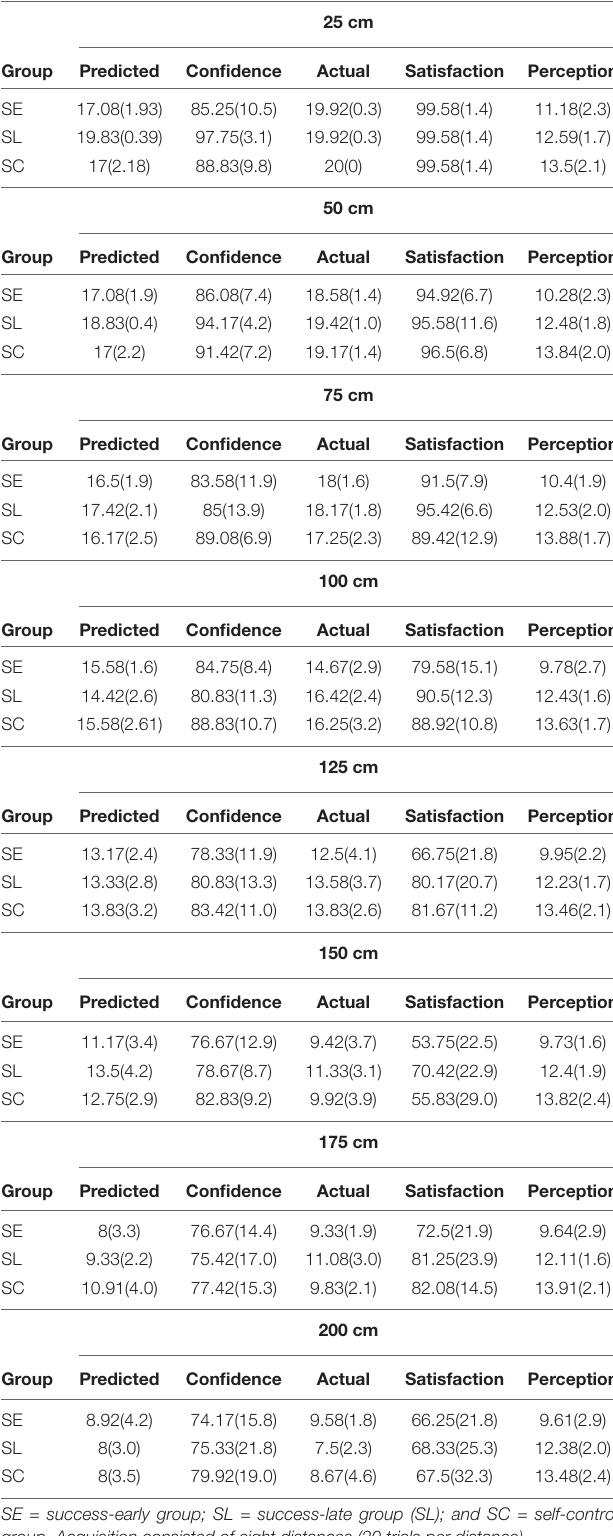
TABLE 1 | Participants’ acquisition means (and standard deviations) for predicted success, confidence levels, actual success, satisfaction levels and perception of putting hole size by experimental group and each putting distance.